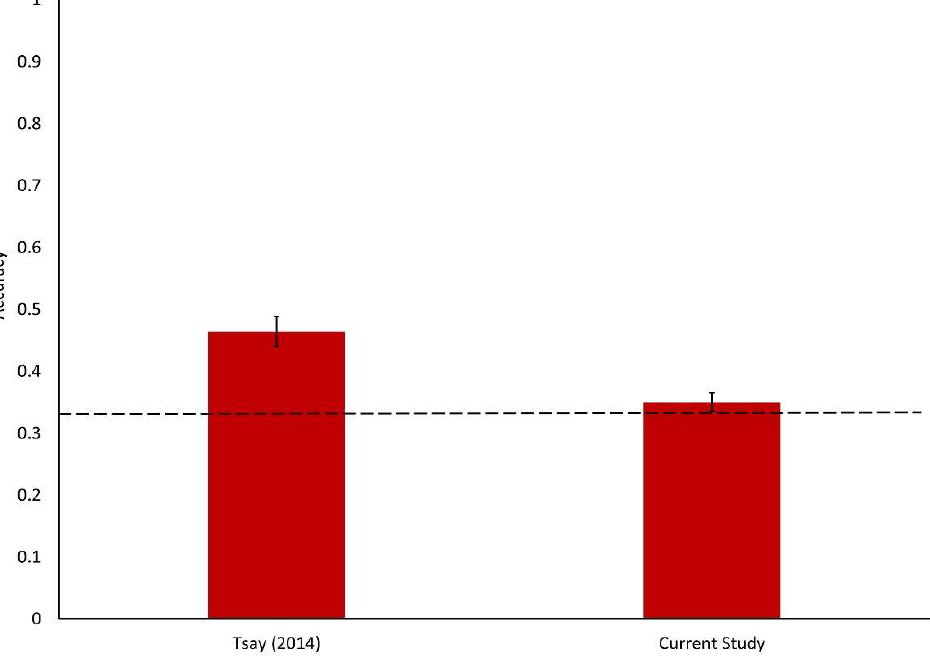
Figure 1. Means and standard errors for accuracy of assessment for Tsay (2014) and the current study. Dashed line indicates chance performance (0.333).